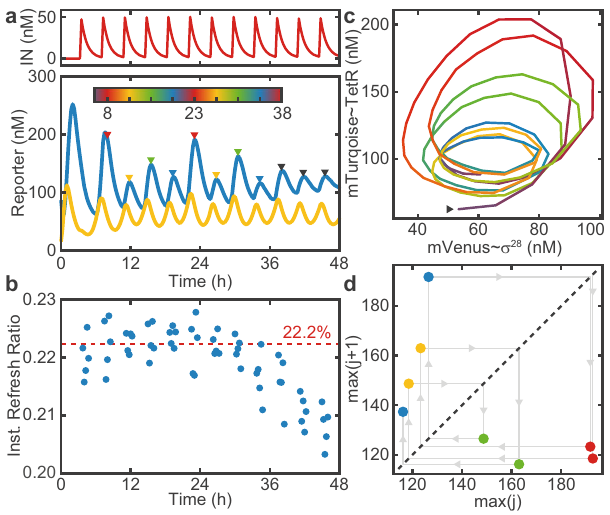
Fig. 5 Period doubling. a Time traces of a 4-cycle ( λ = 1.20). b The instantaneous refresh ratio drops after 36 h due to fatigue. The dashed line indicates the average R t over the fi rst 24 h. c Phase space trajectory. Color indicates time and is scaled to span 4 ⋅ T in , as indicated by the colorbar in a . The arrow marks the starting point of the trajectory, which follows a counter-clockwise path. d Maximum return map for the maxima indicated in a . After the last point, the system transitions to a 1-cycle.